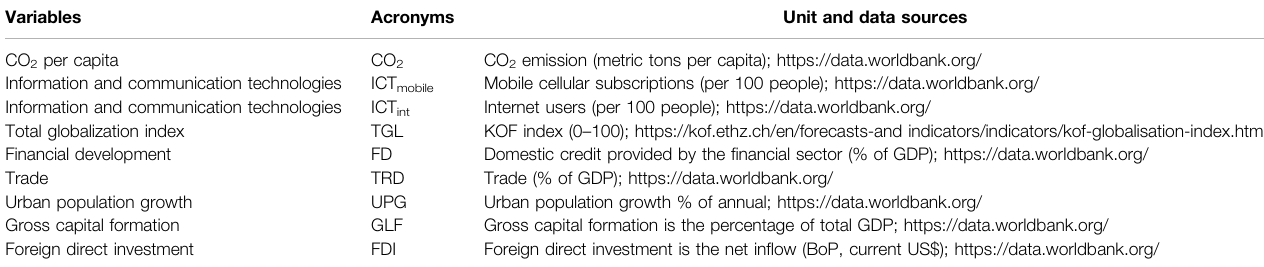
TABLE 2 | Variables, acronyms, and data sources. Variables